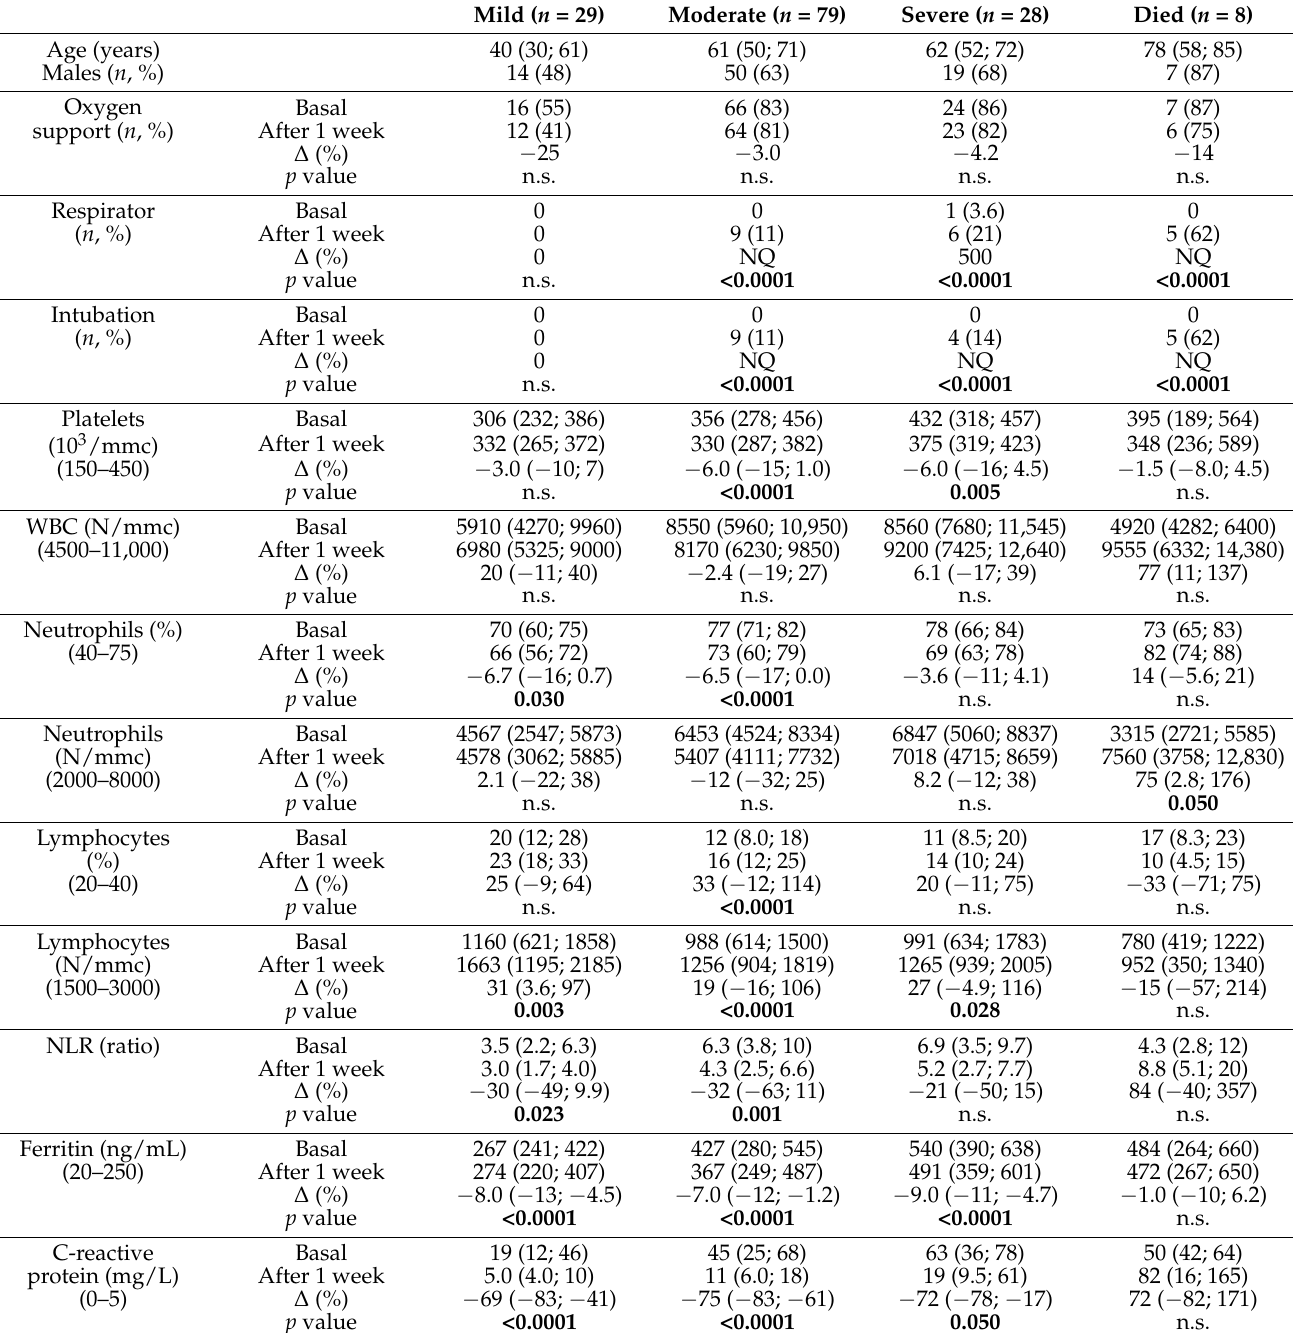
Table 1. Patient